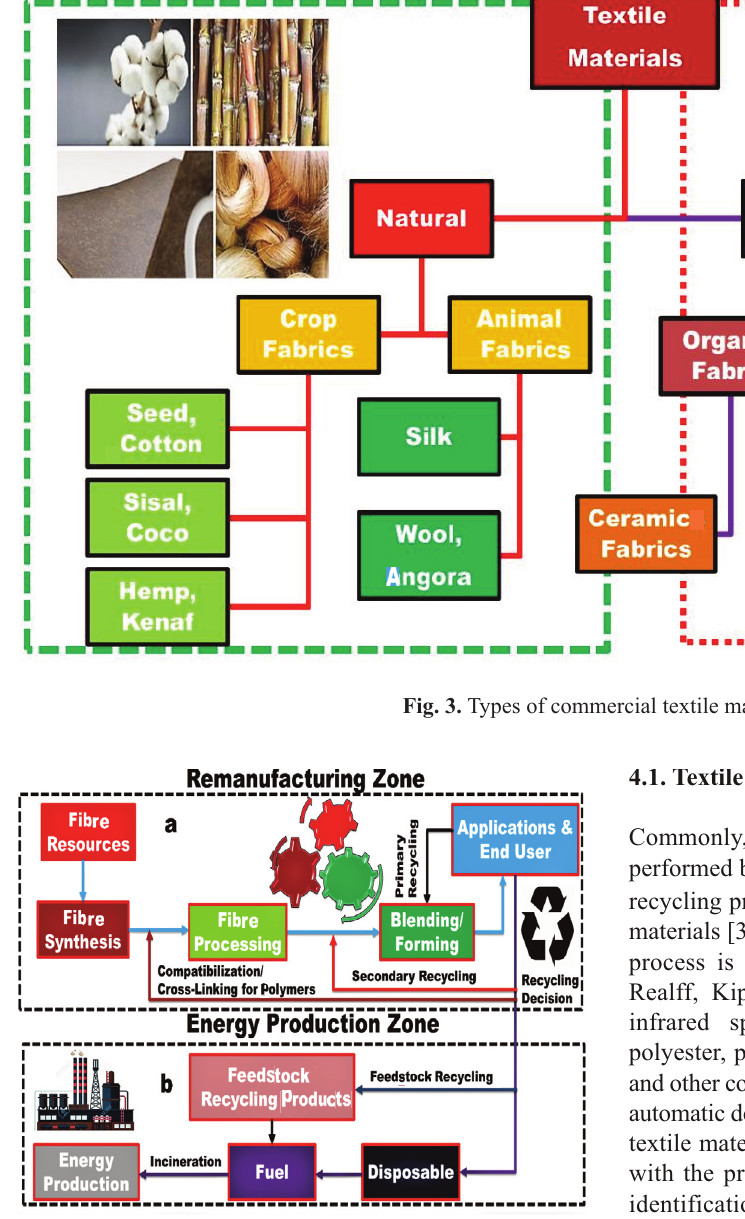
Fig. 4. Recycling flow chart for textile waste: (a) remanufac ­ turing zone; (b) energy production